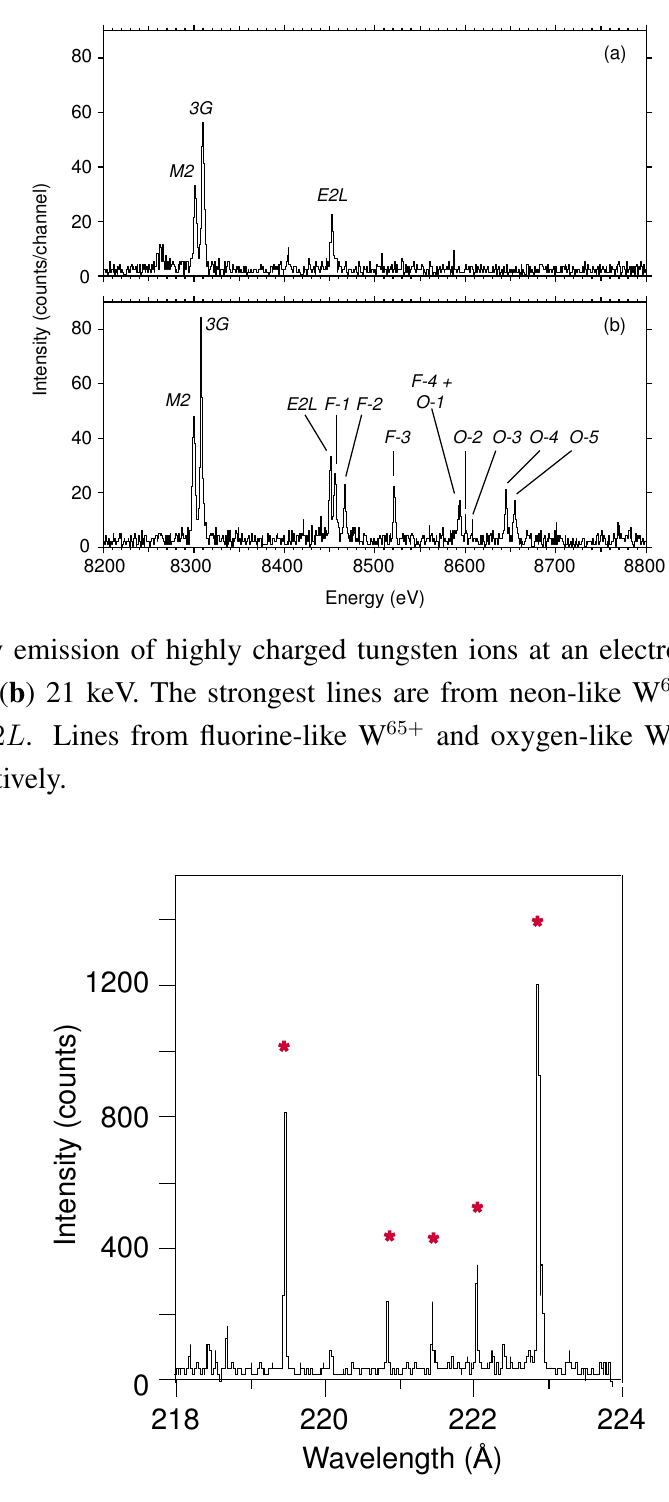
Figure 2. Emission of thulium-like W 5+ in the extreme ultraviolet spectral band. The five lines marked with an asterisk have been newly